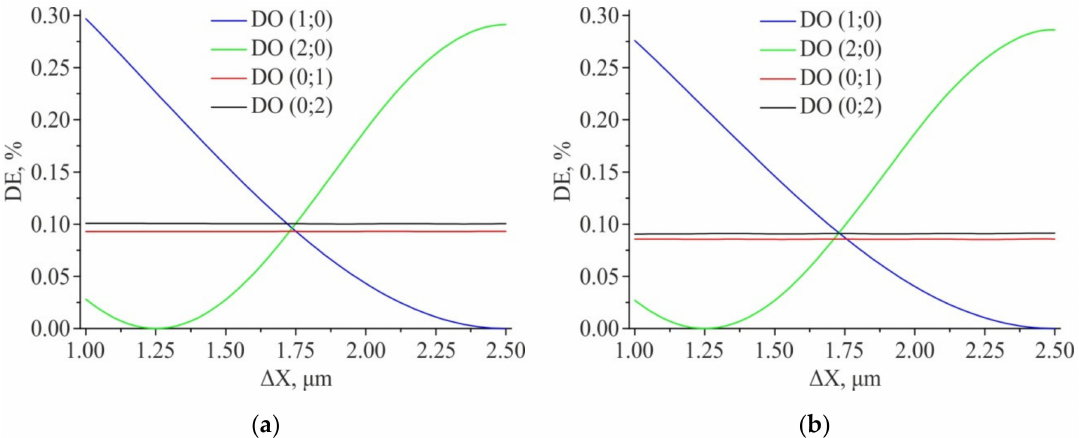
Figure 11. Results of modeling the diffraction efficiency for the amplitude structure 2D DSE ( ∆ Y = const = 1.75 µ m): “Positive” structure ( a ); “Negative” structure ( b ). Feature size—1 µ m × 1 µ